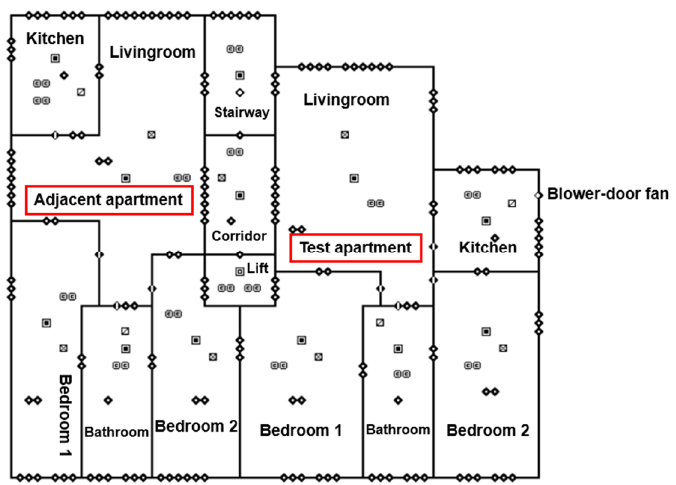
Figure 3. Graphic interface for each floor of the multistory building, where the blower-door fan was only installed in the test apartment.